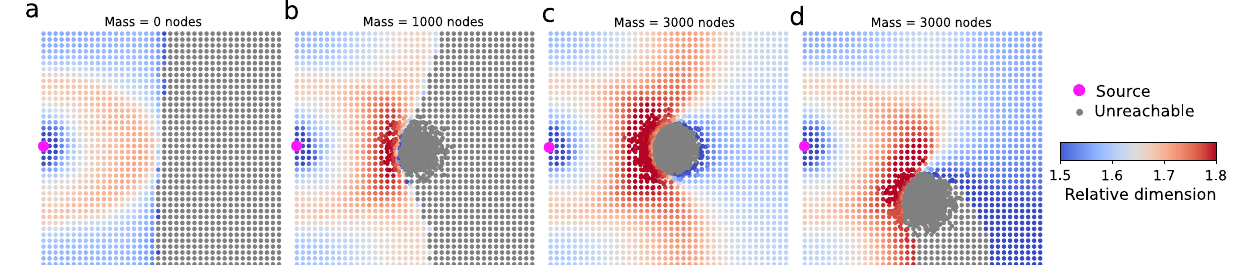
Fig. 2 Inhomogeneities and lensing. The relative dimension from a point source (pink dot) to other nodes in a Delaunay grid graph (edges not shown). Grey nodes indicate nodes for which no transient response peak was detected. The regular grid is shown in a , and an additional mass is added in b – d , with varying mass and position, showing a effect similar to gravitational